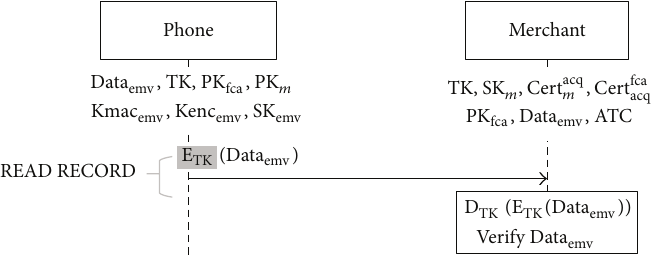
Figure 5: Merchant retrieves data from credit card (modifications are highlighted).